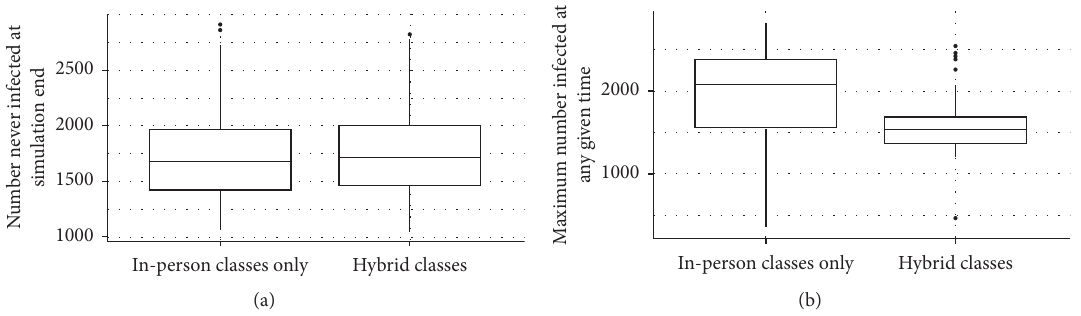
Figure 3: Box plots illustrating the effect of introducing hybrid university classrooms. The left image in (a) shows that there is little difference in the number never infected, while the right image in (b) shows that the maximum number infected at any given time is significantly lower with a hybrid class system. The lower and upper hinges correspond to the first and third quartiles (the 25 th and 75 th percentiles). The upper whisker extends from the hinge to the largest value no further than 1.5 ∗ IQR from the hinge (where IQR is the interquartile range or distance between the first and third quartiles); similarly for the lower whisker. Data beyond the end of the whiskers are outlying points and are plotted